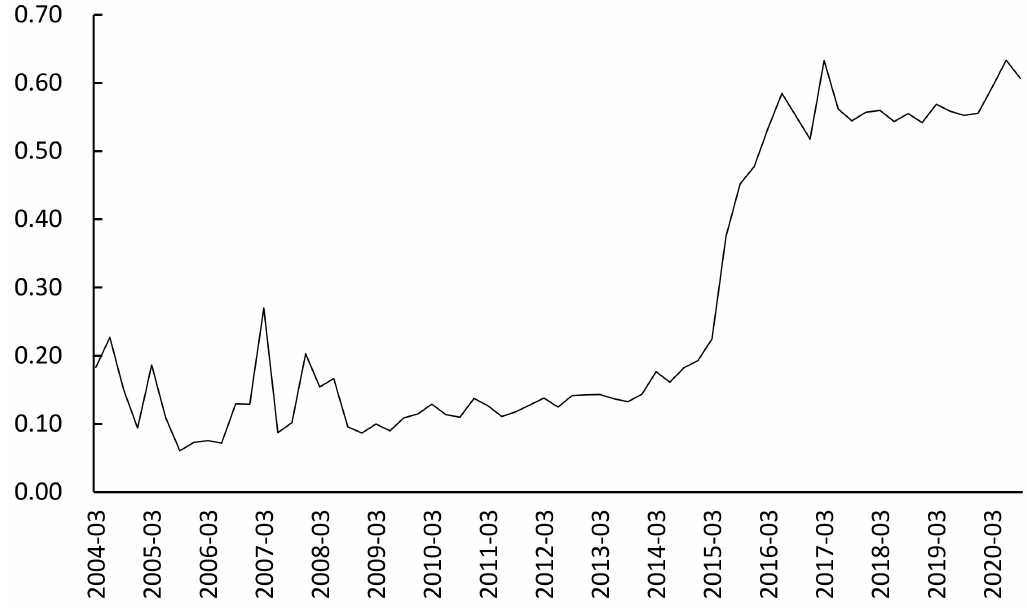
Figure 1. Evolution trend of China’s finance structure index from 2004 to 2020. Source: Own calculation based on Equation